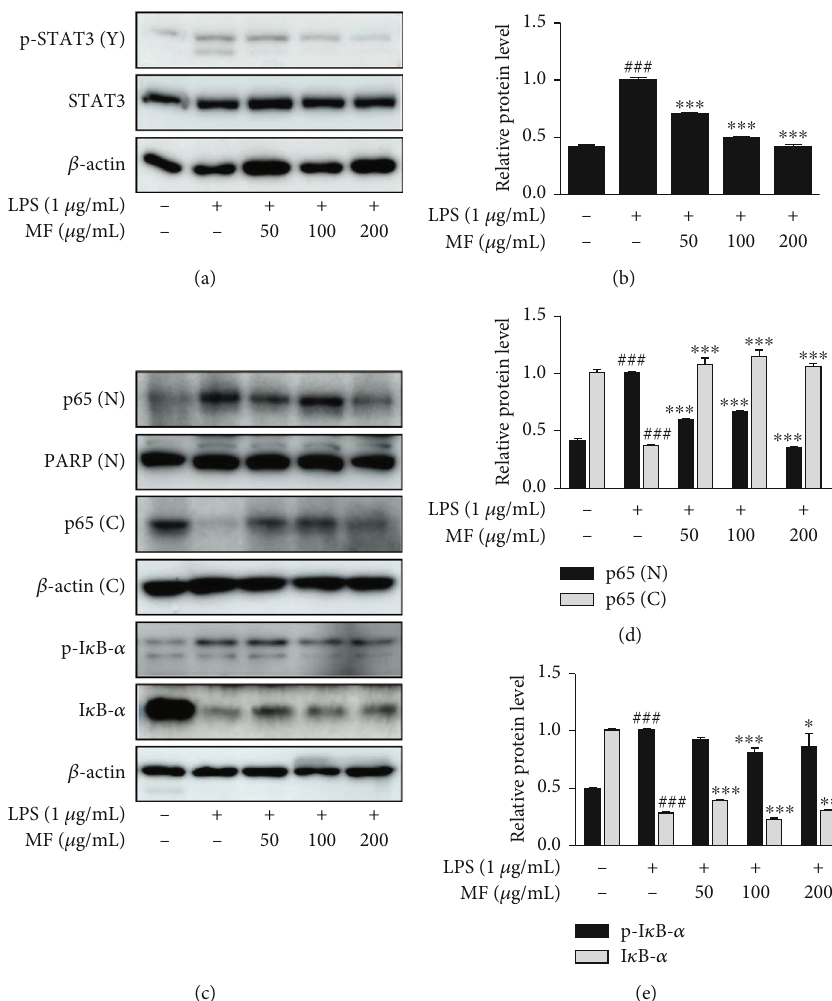
Figure 5: E ff ect of MF on phosphorylation of STAT3 and activation of NF- κ B/I κ B- α in LPS-stimulated RAW264.7 macrophages. The cells were pretreated with MF for 1h prior to the addition of LPS (1 μ g/mL) for either 2 h (a and b) or 15 – 30 min (c – e). (a and b) Total proteins extracted from the cells were evaluated with speci fi c antibodies against STAT3 and pSTAT3 by western blot. (c – e) Nuclear and cytosolic extracts were isolated, and the level of p65 in each fraction, i.e. p65 (N) and p65 (C), and LPS-induced degradation of I κ B- α was examined by western blot. The data are presented as mean ± SD . ### p < 0 : 001 vs. the control group; ∗ p < 0 : 05 and ∗∗∗ p < 0 : 001 vs. the LPS-treated